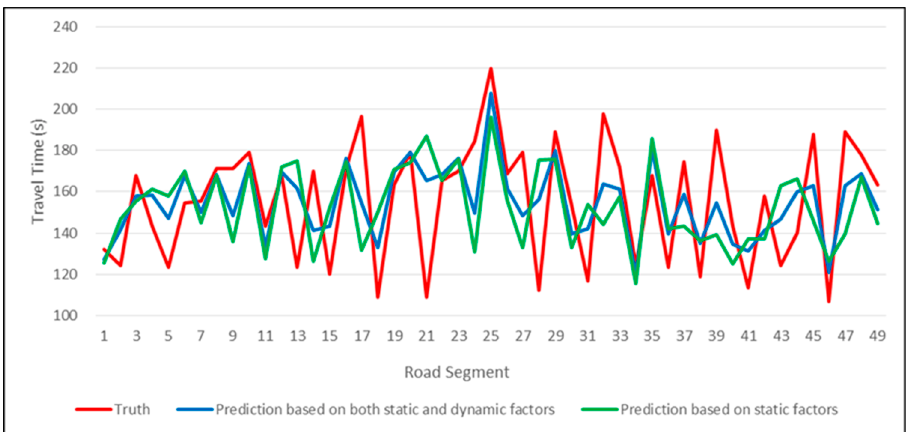
Figure 4. A comparison of the true and predicted values of a data series extracted from the test set. Predictions using dynamic factors are closer to real values than predictions that do not use dynamic factors.